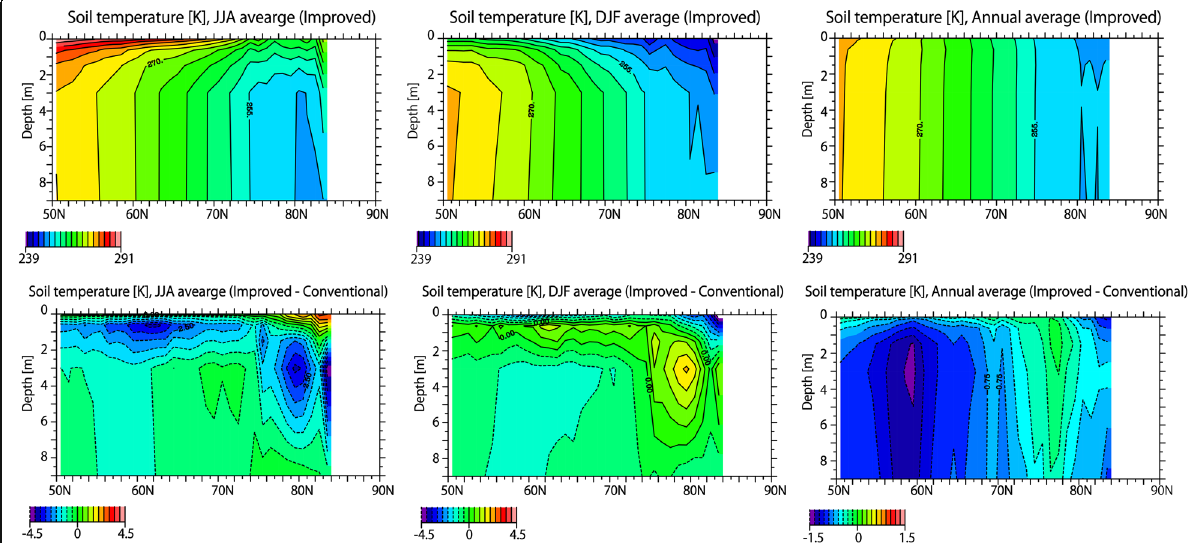
Fig. 3 Latitudinal distributions of soil temperature in the historical simulations. Upper panels: the JJA, DJF, and annual average of soil temperature for the year 2000 in the improved version. Lower panels: the same as the upper panels but showing the differences between the improved and conventional versions. Vertical axis represents the soil depth [m], and the longitudinal average over land is shown. The average simulations with the atmospheric forcings of all five GCMs is